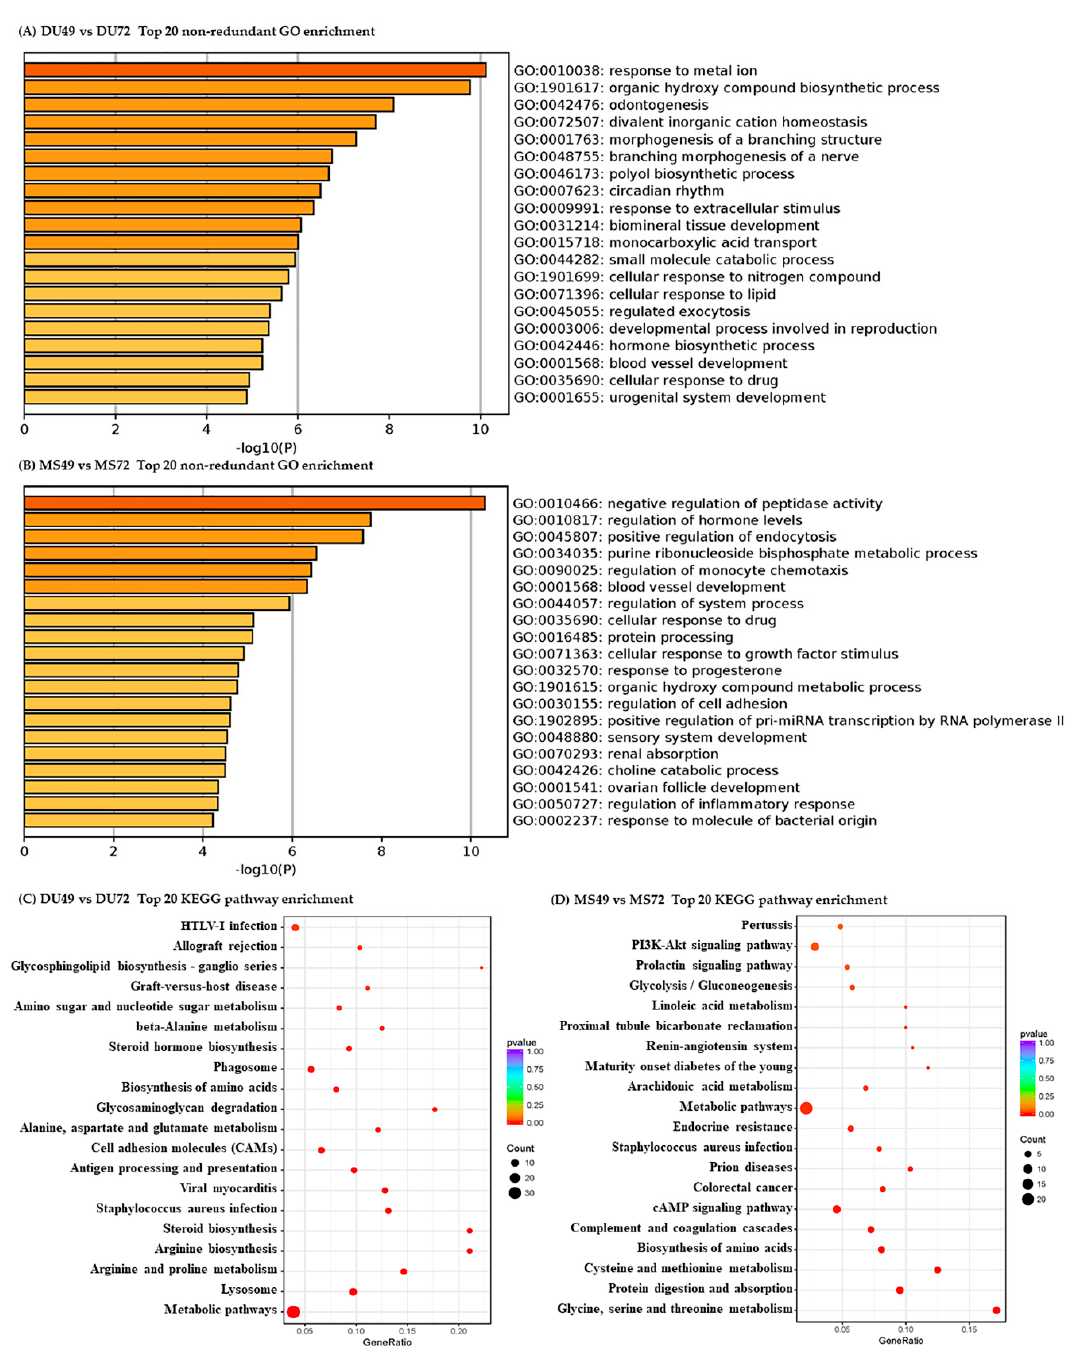
Figure 2. Pathways clustered from DEGs detected between GD49 and GD72. Top 20 non-redundant enriched gene ontology (GO) terms ( A , B ) and top 20 enriched KEGG pathways ( C , D ).